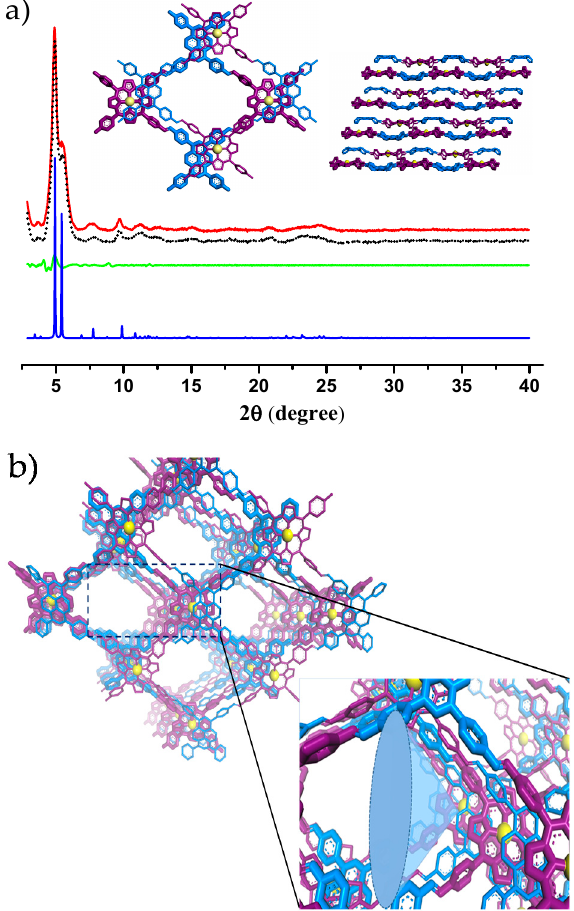
Figure 1. ( a ) PXRD patterns of Co(II)TA-TF COF with the observed profiles in red, refined in black, difference in green and calculated in blue. Insert: the TA-TF AA structure with a slipping distance